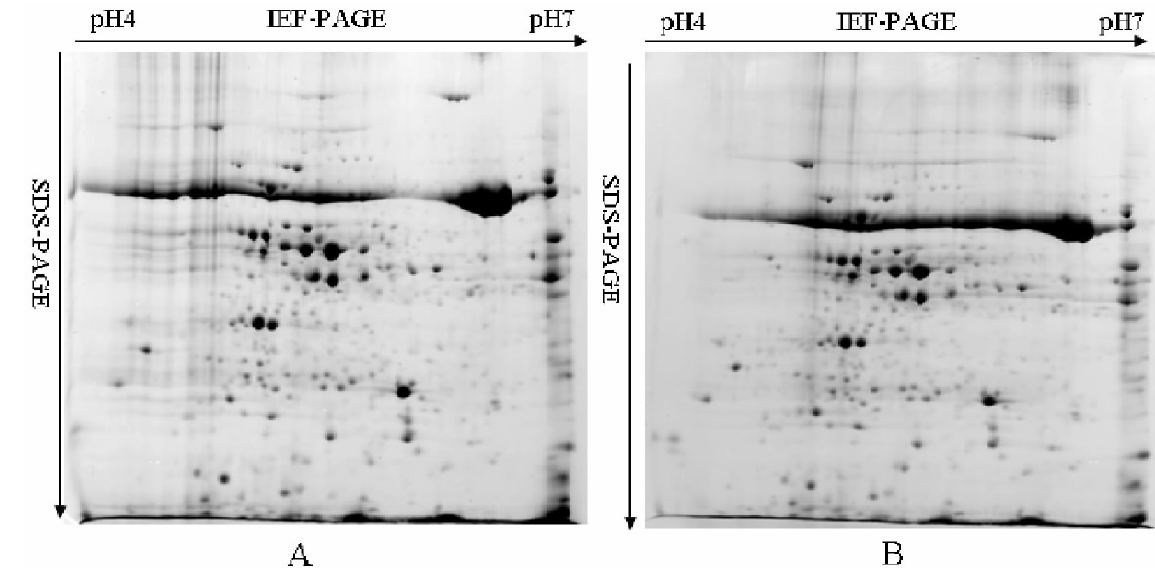
Figure 4. 2-DE patterns of leaf albumins and globulins from Chinese Spring ( A ) and 3BS-8 ( B